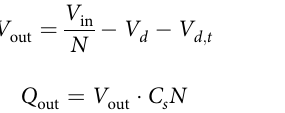
Fig. 4e – g, demonstrating powerfully the step-down ability of FSCC and the great negative in fl uence of V d,t on the output for 1st order FSCC. In order to achieve ef fi cient energy transmis- sion, the fractal property is considered to redesign the switched- capacitor-convertor to effectively reduce the in fl uence of voltage drop. With 2nd and 3rd order 24-unit FSCC, total output voltage drop V d,t can be effectively reduced to 8 V d and 6 V d in theory. Correspondingly, the experimental output is enhanced by three times, and the V d,t decreases from 6.61 to 1.12 V (Fig. 2e, f and Supplementary Fig. 5). In summary, fractal design can effectively enhance conversion ef fi ciency of SCC.